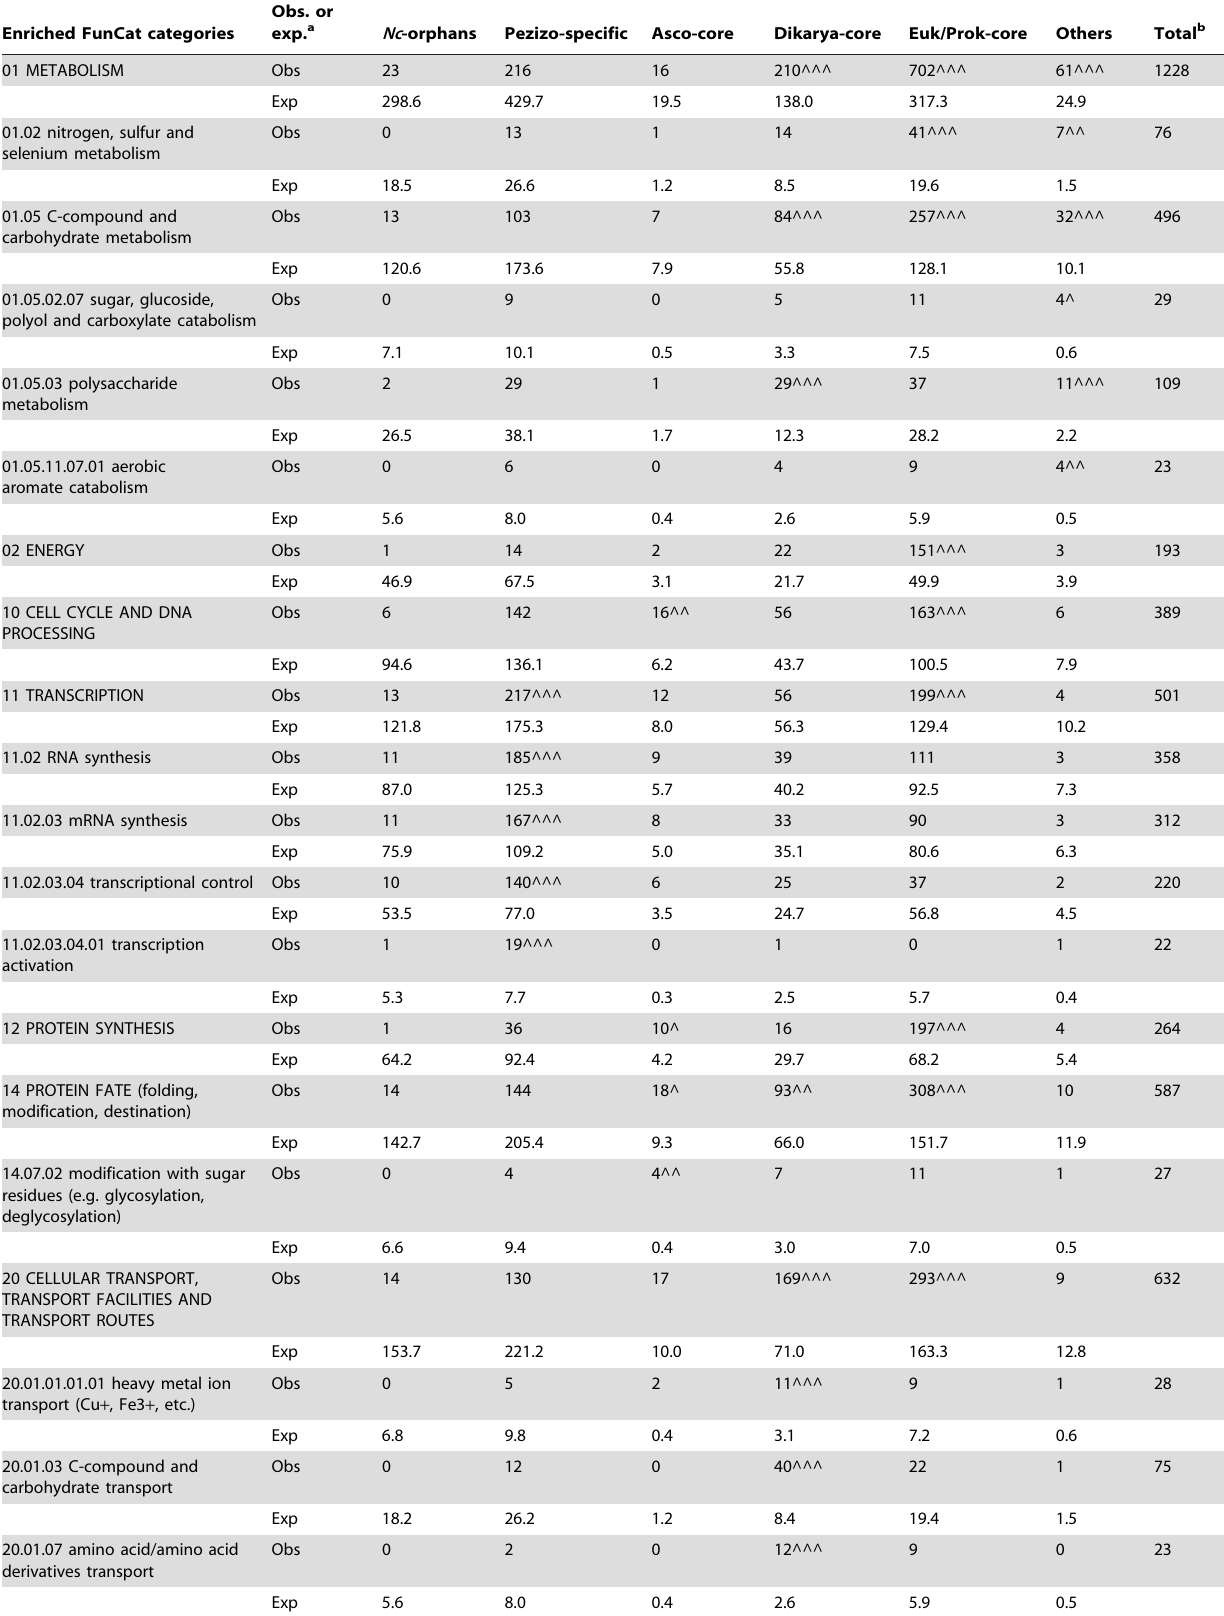
Enriched FunCat